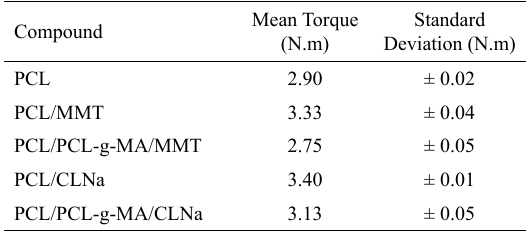
Table 3. Torque of PCL compounds. Compound